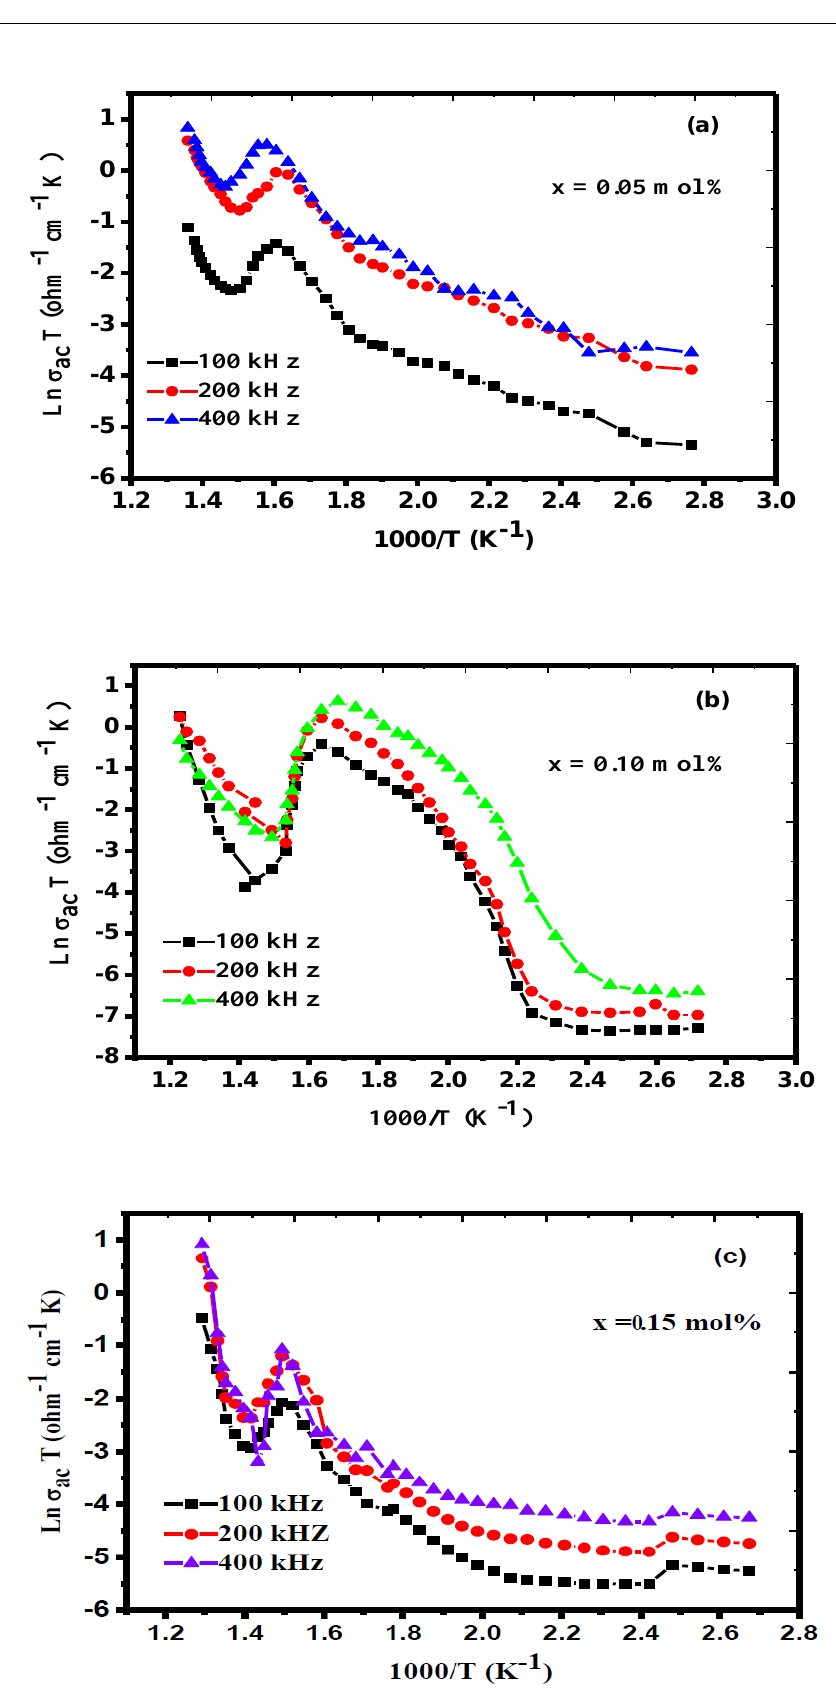
Figure 6. Variation of ac conductivity of Co x :K 2 Ti 6 O 13 ceramics with temperature; ( a ) is for Co 0.05 :K 2 Ti 6 O 13 , ( b ) is for Co 0.10 :K 2 Ti 6 O 13 and ( c ) is for Co 0.15 :K 2 Ti 6 O 13